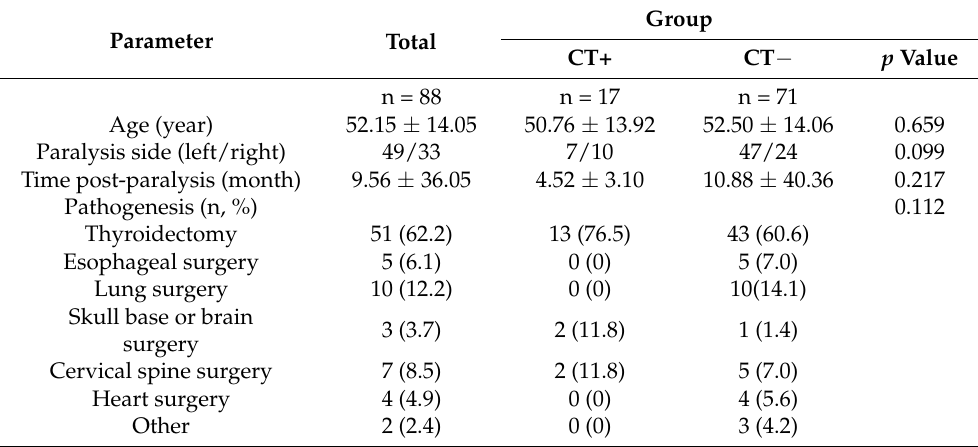
Figure 2. Flowchart of patient recruitment, exclusion, group assignment, and analysis. TA = thyroarytenoid–lateral cricoarytenoid muscle complex; CT = cricothyroid muscle; LEMG = laryngeal electromyography. Table 1. Patient characteristics of the study groups.